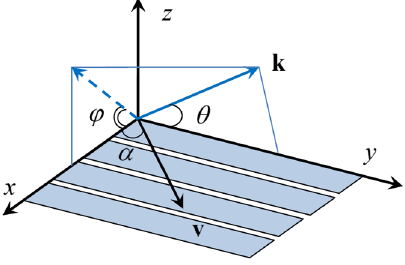
FIG. 5. Schematic convention of the axes.